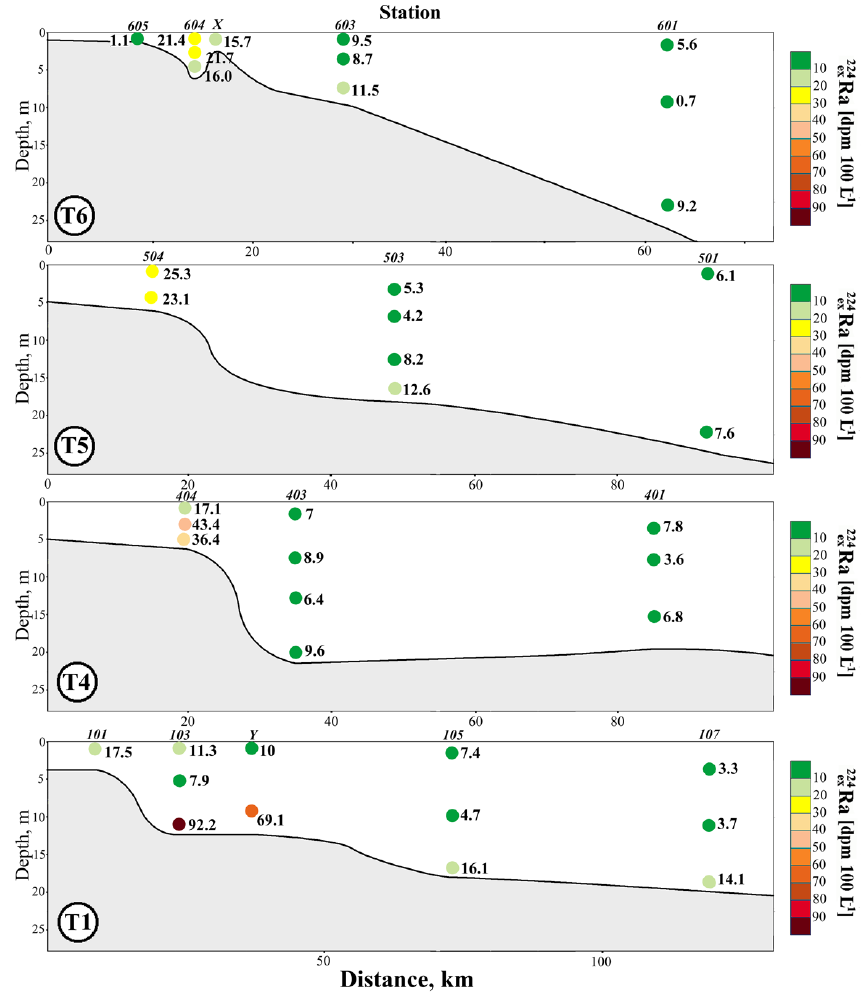
Figure 11. Summer (September 2013) vertical distribution of ex 224 Ra in the Lena Delta. Sta Y (72 ◦ N, 130 ◦ E) is included in transect